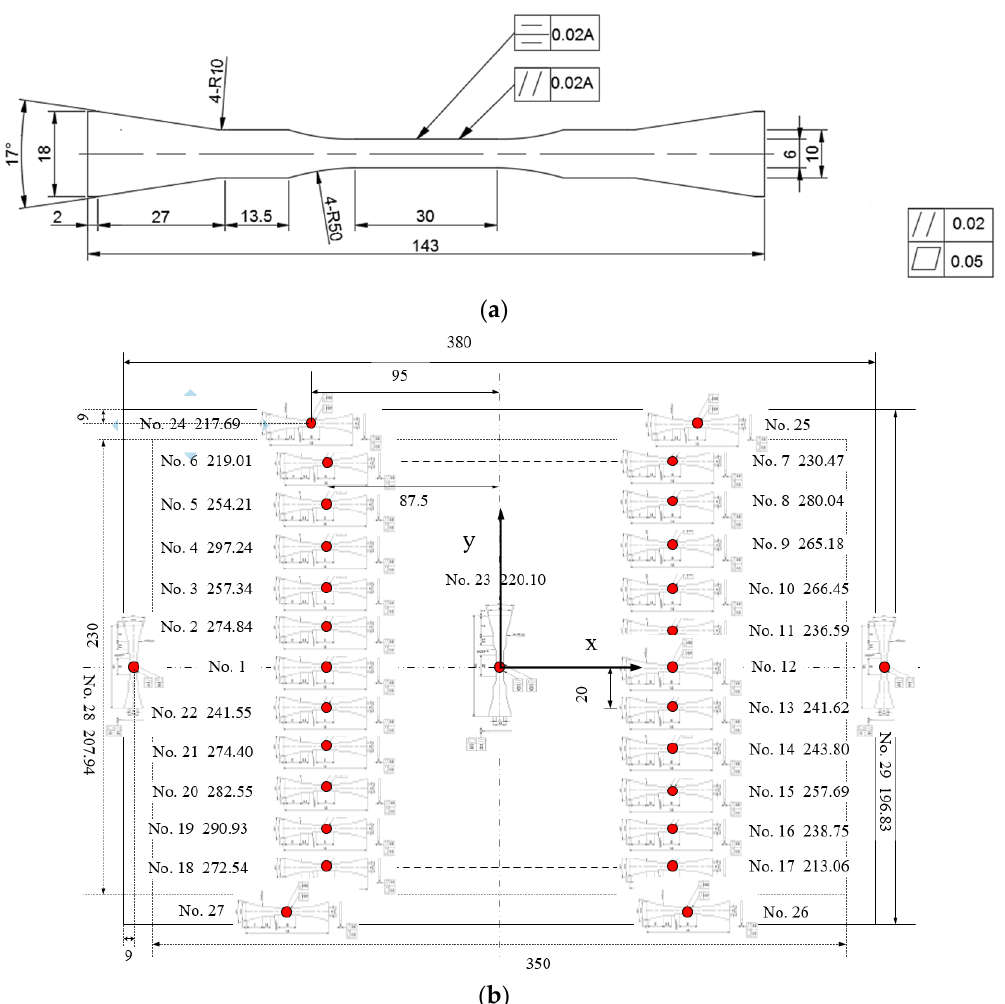
Figure 9. The configuration, dimensions, locations, series number and experimental results of the residual strength specimen. ( a ) The configuration and dimensions of the tensile residual strength specimen. ( b ) The locations and series number of the residual strength specimen. specimen. ( b ) The locations and series number of the residual strength